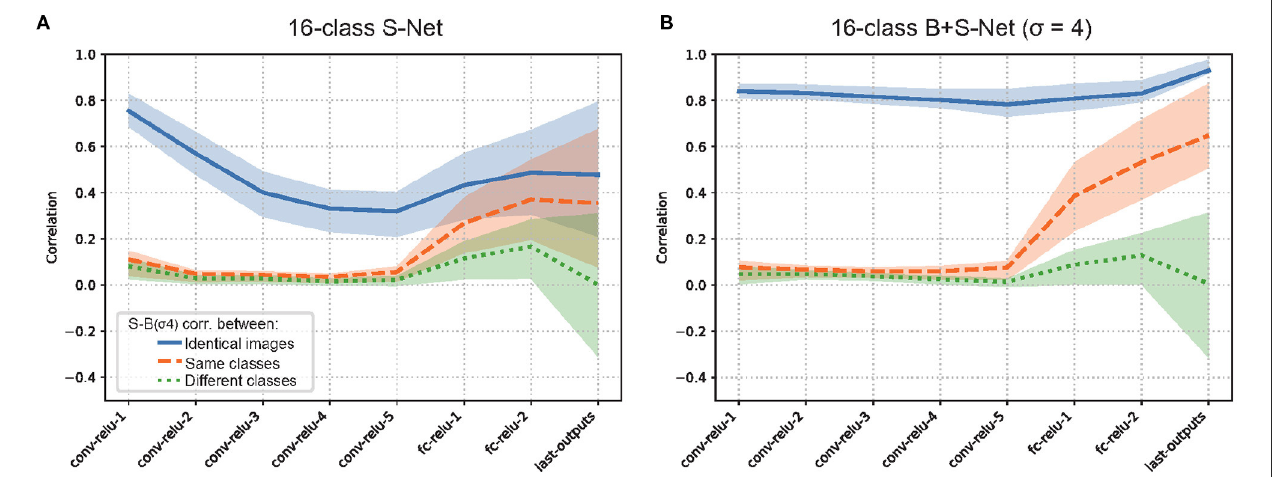
FIGURE5 Representational similarity of sharp (unblurred) and blurred image inputs (S-B correlation) for S-Net (A) and B+S Net (B) . Blue: Pearson correlation in unit activity between sharp and blurred versions of the identical images. Orange: Correlation between sharp and blurred versions of different images of the same object class. Green: Correlation between sharp and blurred versions of different images of different object classes. The average correlation of the units in the layer with the interquartile range (25%-75%) is shown. 16-Class AlexNet. The results are consistent with Case 1.